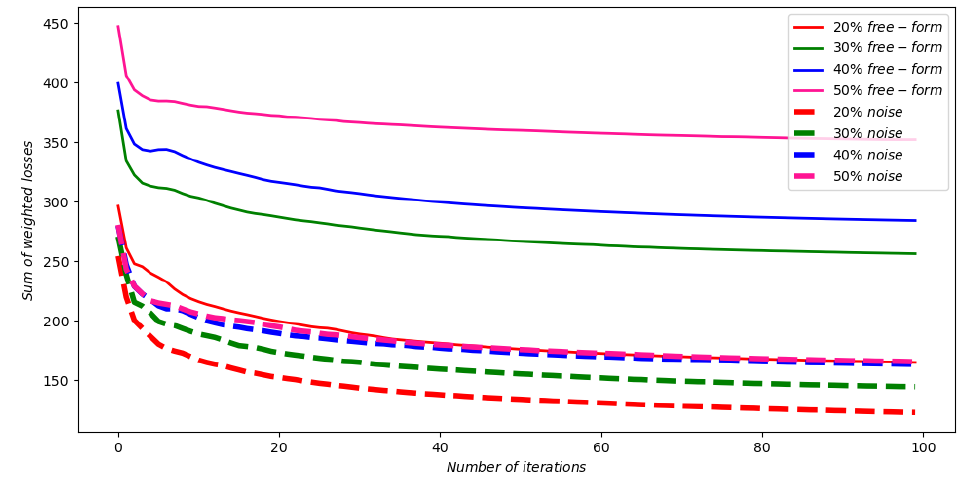
Figure 13. The graph of the total weighted loss changes during the iterative inpainting process.